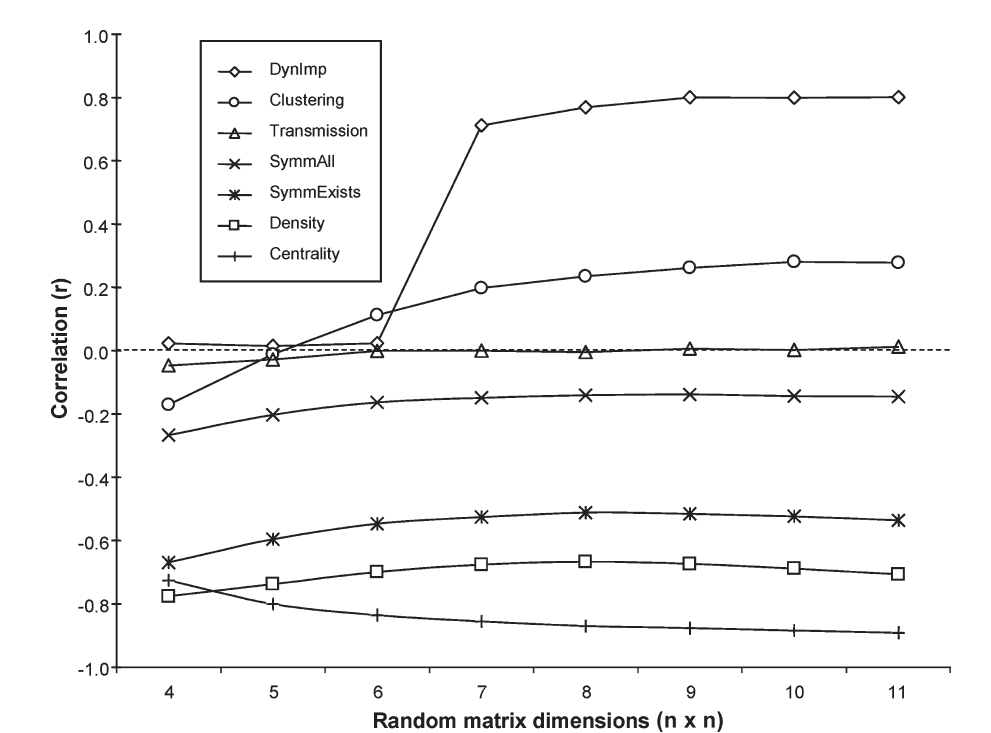
Figure 5. Relationship between matrix size and nodal measure correlations with Shapley values, as derived from a set of 5000 randomly generated matrices . Dynlmp ¼ dynamical importance (Restrepo et al., 2006).